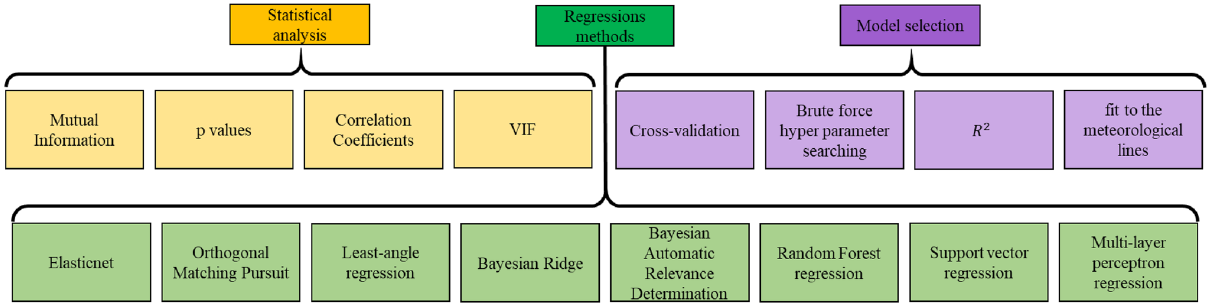
Figure 3. Yellow, green and violet boxes show the techniques used in the statistical analysis step, the regression methods available in Isocompy and the implemented techniques in the model selection steps, respectively.